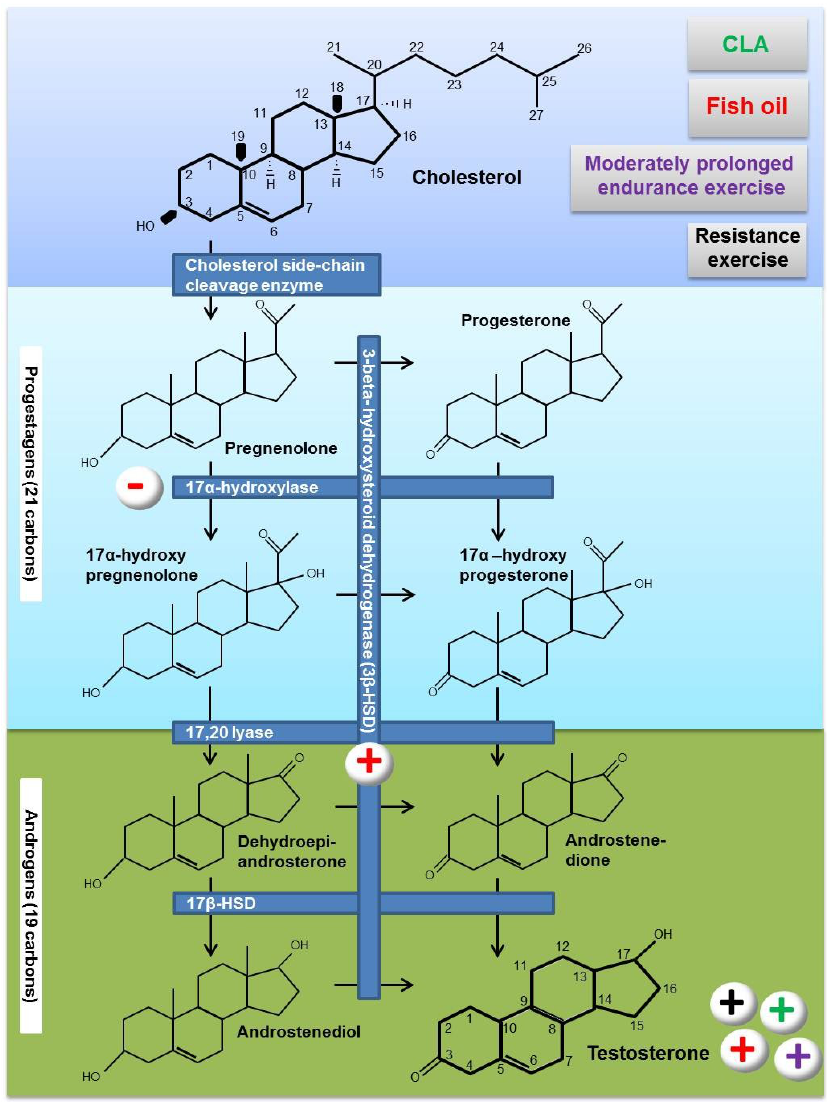
Figure 2. Potential effects of fat supplements and exercise on testosterone biosynthesis. The hydroxylase enzymes involved in the synthesis of testosterone have a nomenclature that indicates the site of hydroxylation (e.g., 17α-hydroxylase introduces a hydroxyl group to carbon 17) or the site of hydroxylation in addition to being identified as P450 class enzymes (e.g., the 17α-hydroxylase is also identified as P450c17). The officially preferred nomenclature for the cytochrome P450 class of enzymes is to use the prefix CYP (e.g., 17α-hydroxylase should be identified as CYP17A1). The symbols + and − indicate the over or the under expression of a specific enzyme or hormone stimulated by one of the conditions indicated with different colors (red: fish oil supplementation; green: CLA supplementation; black: resistance exercise; purple: moderate prolonged endurance